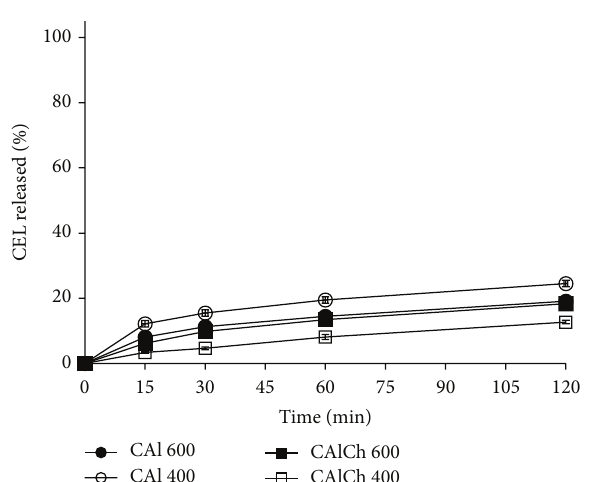
Figure 8: Celecoxib release profiles in phosphate buffer at pH 7.4.